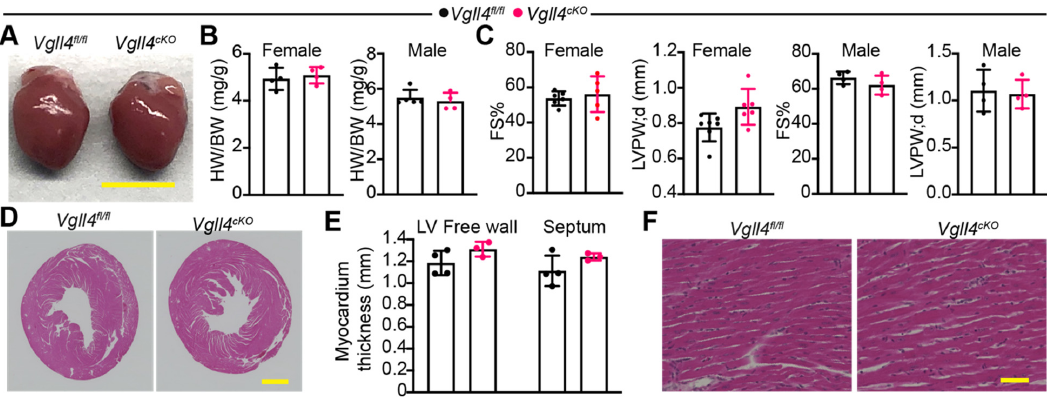
Figure 6. CM-specific depletion of VGLL4 does not affect myocardial growth and heart function: ( A ) gross morphology of control ( Vgll4 fl/fl ) and Myh6-Cre; Vgll4 fl/fl ( Vgll4 cKO ) hearts at 8 weeks after birth. Scale bar = 5 mm; ( B ) heart-to-body weight ratio. N= 4–5; ( C ) echocardiography measurement of heart function and ventricle wall thickness. FS%, fraction shortening. LVPW, d: left ventricle posterior wall thickness; diastolic. N = 5–6; ( D ) H&E-stained heart cross-sections. Scale bar = 1 mm; ( E ) left ventricle wall and septum thickness; ( F ) longitudinal view of CM alignment. Scale bar = 50 µm.